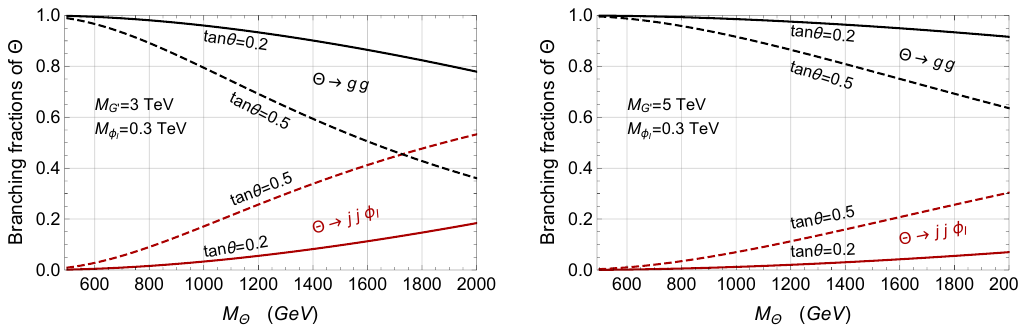
jj(cid:30) I ! jj(cid:30) I . The coloron mass used !